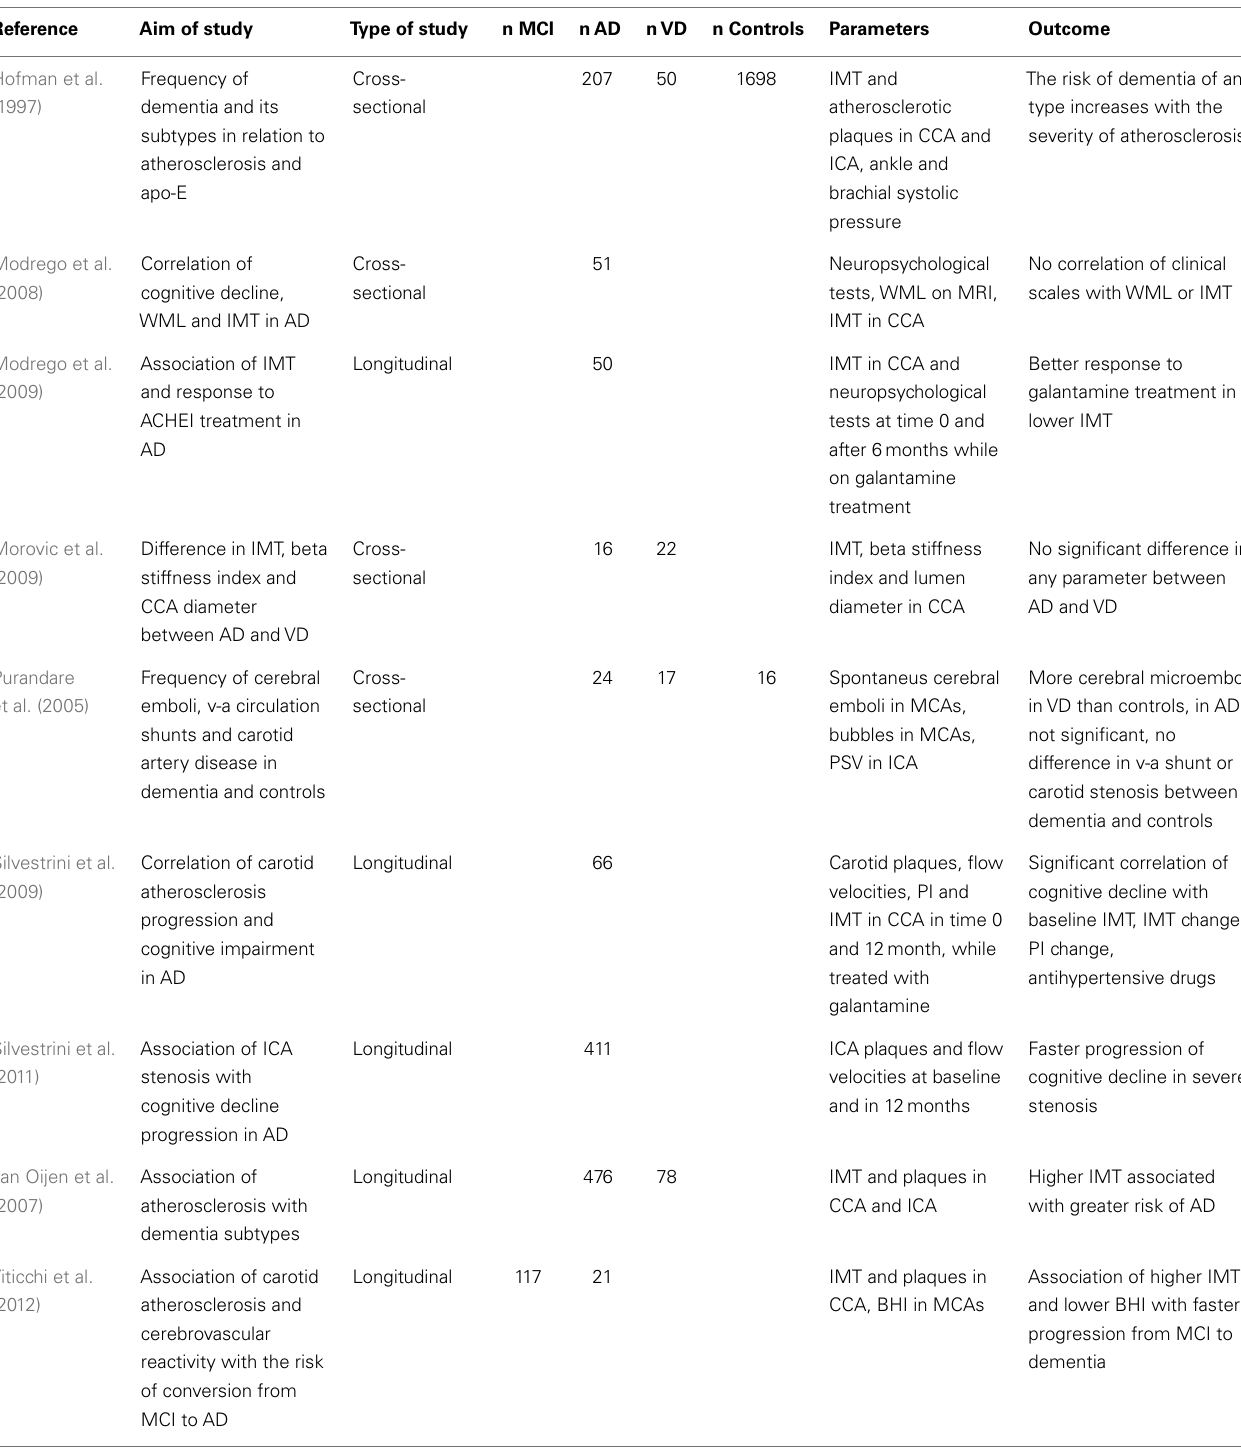
Table 1 | IMT and carotid